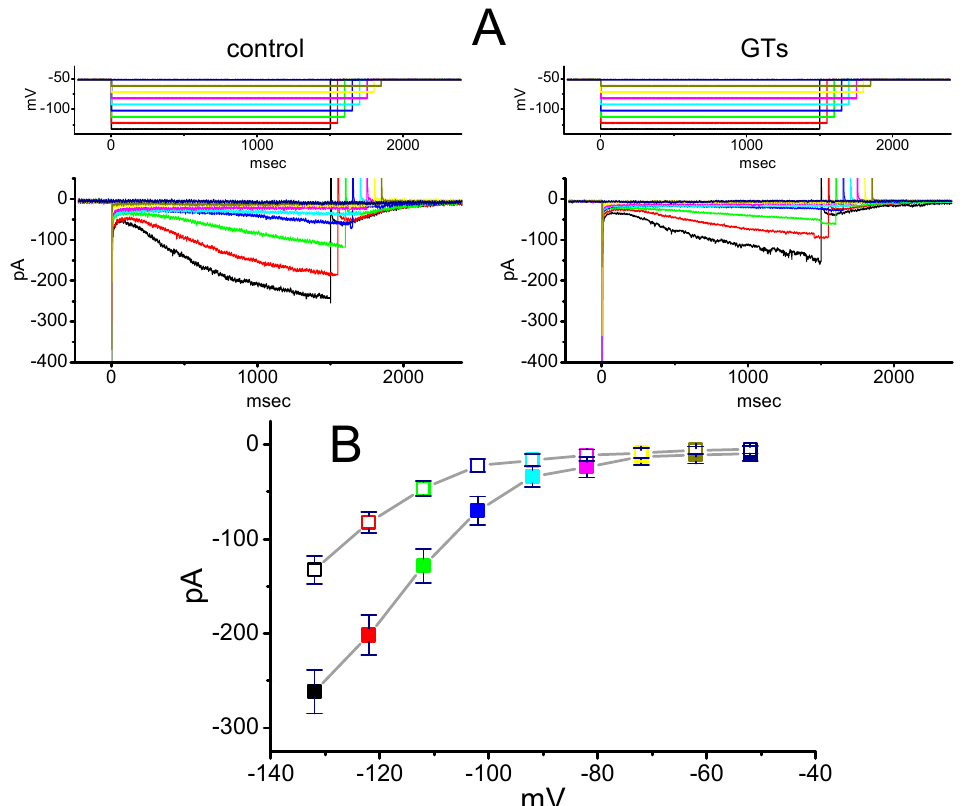
Figure 2. Effect of GTs on average current–voltage ( I–V ) relationship of I h recorded from GH 3 cells. The examined cell was maintained at − 52 mV and a series of voltage steps ranging from − 132 to − 52 mV from a holding potential of − 52 mV in 10-mV increments was thereafter applied. (A) Superimposed I h traces in the absence (left, control) and presence (right) of 10 µg/mL GTs. The upper part in each panel indicates the voltage protocol used. Notably, during our voltage-clamp recordings, colored labeling in each current trace (lower part) in the absence (left) and presence (right) of GTs corresponds to that in voltage trace (upper part). (B) Averaged I–V relationships of I h amplitude with or without the GTs addition (mean ± SEM; n = 8 for each point). The examined cells were voltage-clamped at − 52 mV, current amplitude was then taken at the end of each hyperpolarizing step, and colored labeling in each point corresponds to that in (A). Closed symbols: control; Open symbols: in the presence of 10 µg/mL GTs.